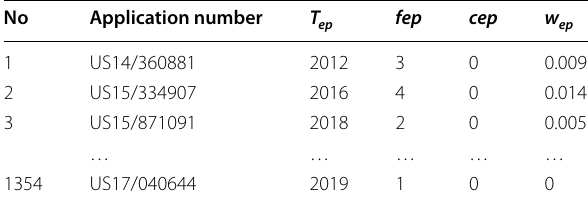
Table 5 Weights of patent edges in hypergraph Table 6 Weight of function